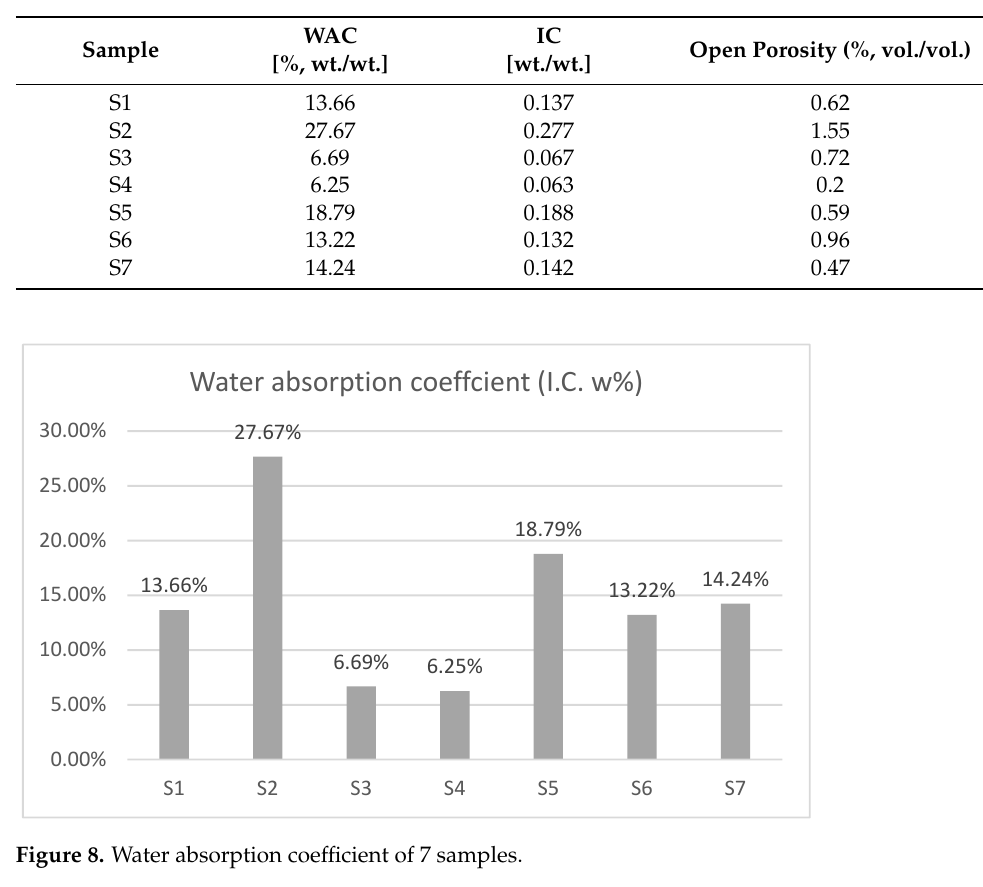
Table 3. Water absorption capacity (WAC, weight per weight [wt./wt.]), imbibition capacity (IC,